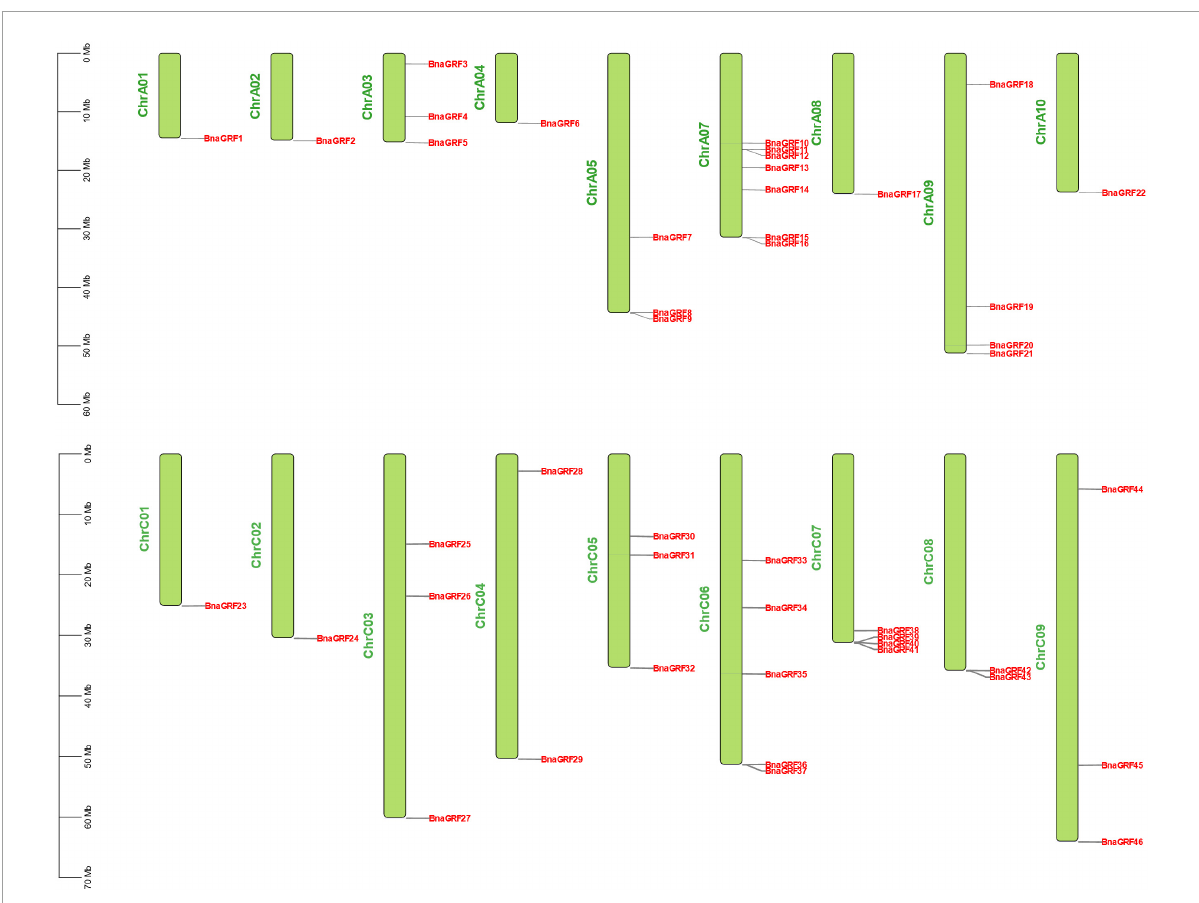
FIGURE4 Chromosomal mapping of 46 BnaGRFs . The length of chromosomes is represented in Mb. The chromosome number is presented on the left side of each chromosome. BnaGRFs are marked in red.